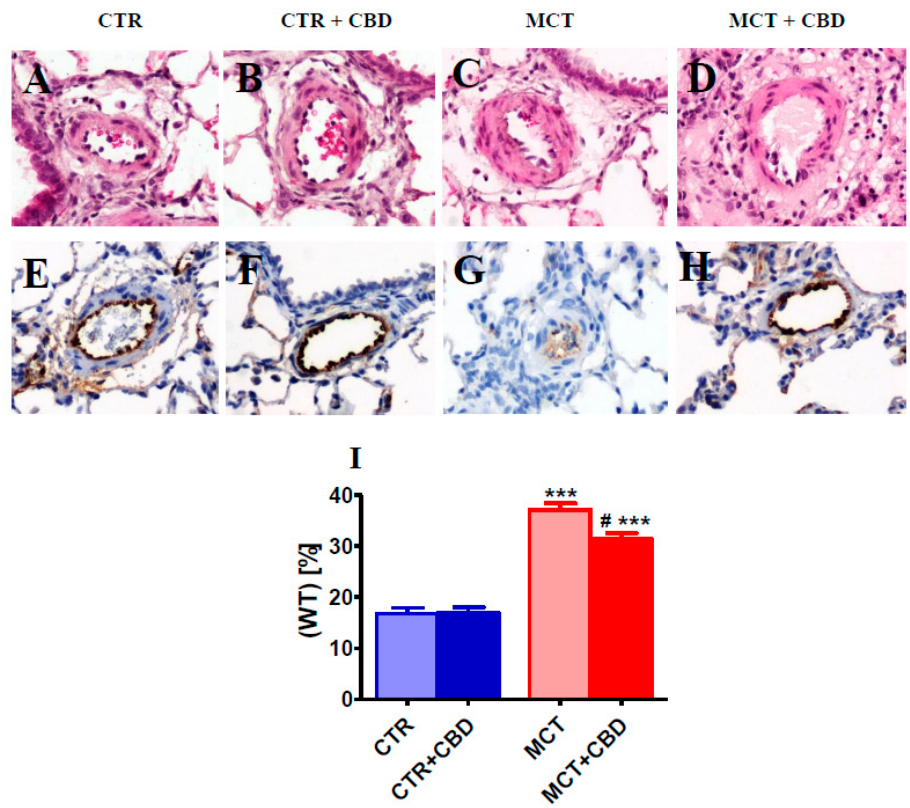
Figure 2. The effect of chronic administration of cannabidiol (CBD) on pulmonary vascular remodeling ( A – D , I ) and von Willebrand factor immunoreactivity ( E – H ) in the rat pulmonary small arteries. Representative images of occluded vessels (only found in MCT-induced pulmonary hypertension ( G )) and percentage of medial wall thickness (WT.%) ( I ) are presented as mean ± SEM in n = 8 per group. CBD 10 mg/kg or its vehicle was injected intraperitoneally every 24 h for 21 days. Representative photomicrographs magnification 200×. CTR—control, MCT—monocrotaline. # p < 0.05, *** p < 0.001 compared to the respective control groups (* CTR or # MCT).